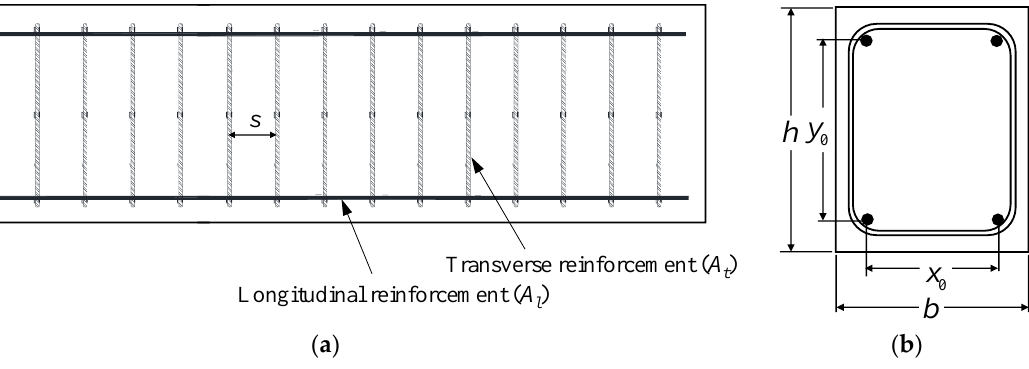
Figure 1. Cross- and longitudinal sections of specimens: ( a ) cross-section ( b ) longitudinal section. The database consists of a total of 37 specimens, including seven NCA control speci-